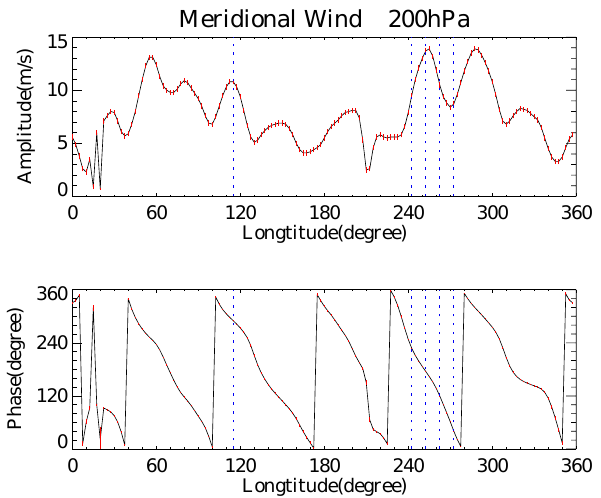
Fig. 11. Similar to Fig. 10., but for zonal wind disturbance at 10hPa during December